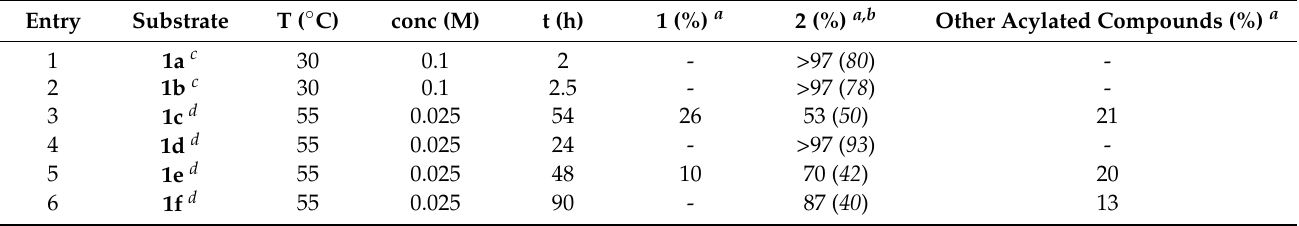
Table 1. Regioselective enzymatic acylation of ribonucleosides 1 .